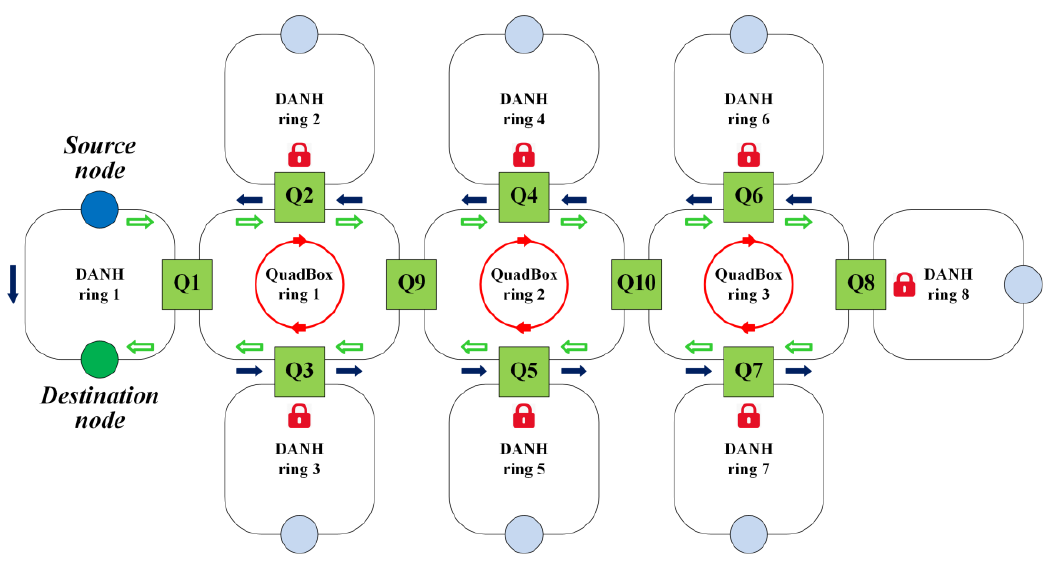
Figure 12. Network traffic under the port locking (PL) approach in Case